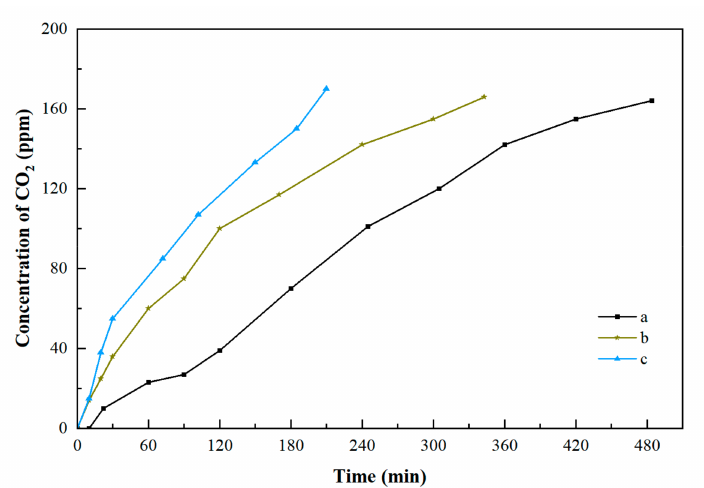
Figure 10. Breakthrough curves of Zn-13X at 20 ◦ C, where (a) fresh adsorbent, (b) once regeneration adsorbent and (c) twice regeneration adsorbent,